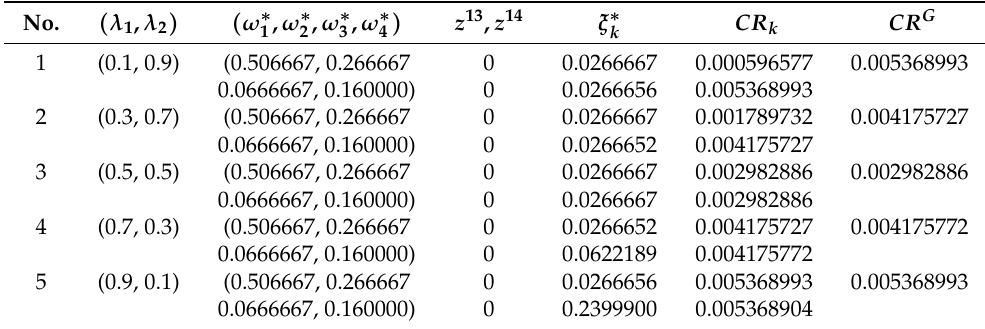
Table 6. Result of Example 1 solving with